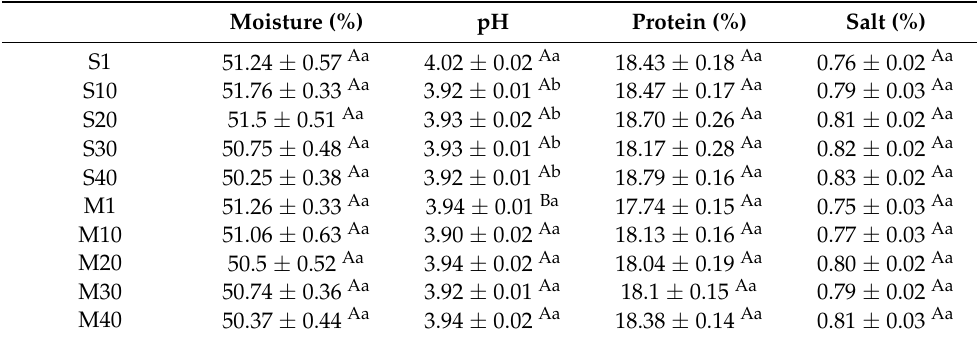
Table 1. The pH, moisture, protein and salt content of cheese.